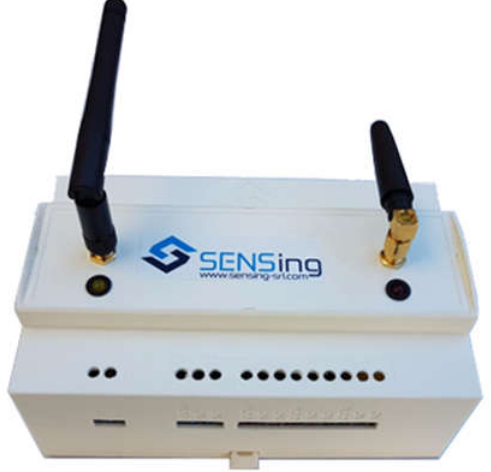
Figure 11. The complete sensing node prototype with the solar panel and the antenna that can be directly connected to the node ( a ) or placed apart from the sensing area ( b ).